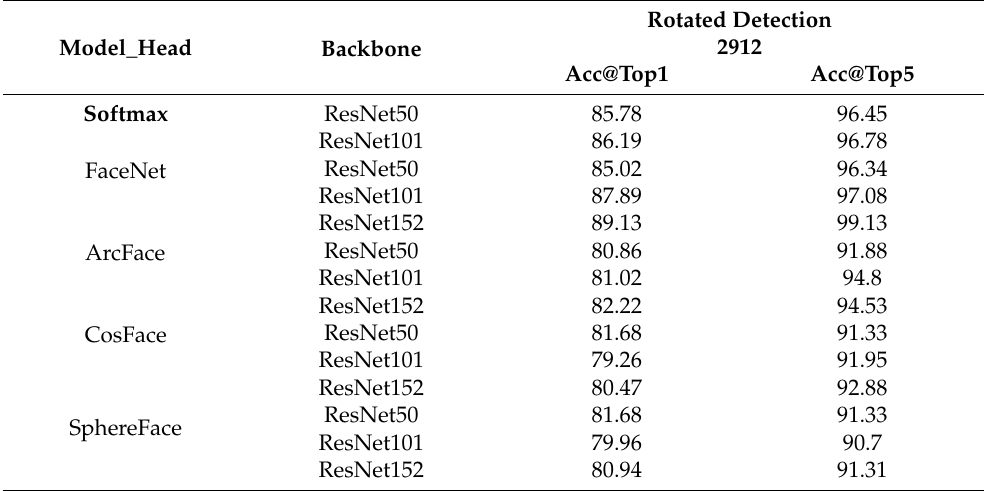
Table 7. Comparative experiment of traditional identification network. The data are a picture after being rotated and cropped. FaceNet achieved the best performance among the different backbones.